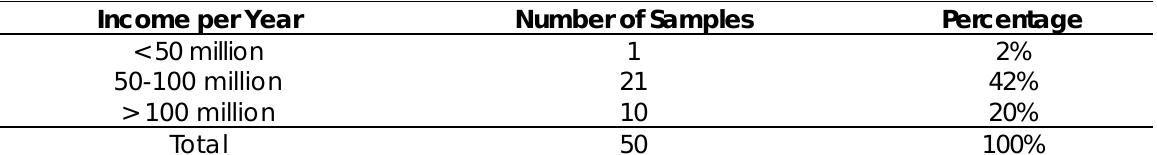
Distribution of Sample Based on Income per